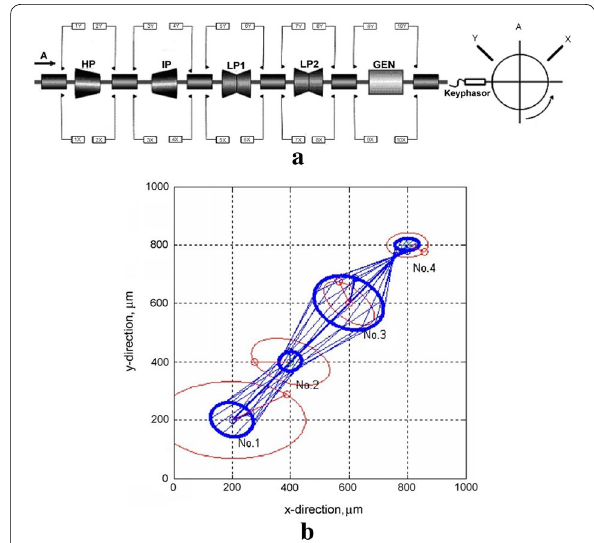
Figure 20 Balancing results of Liu et al. [83]: a Structure of turbo-generator; b Balancing results